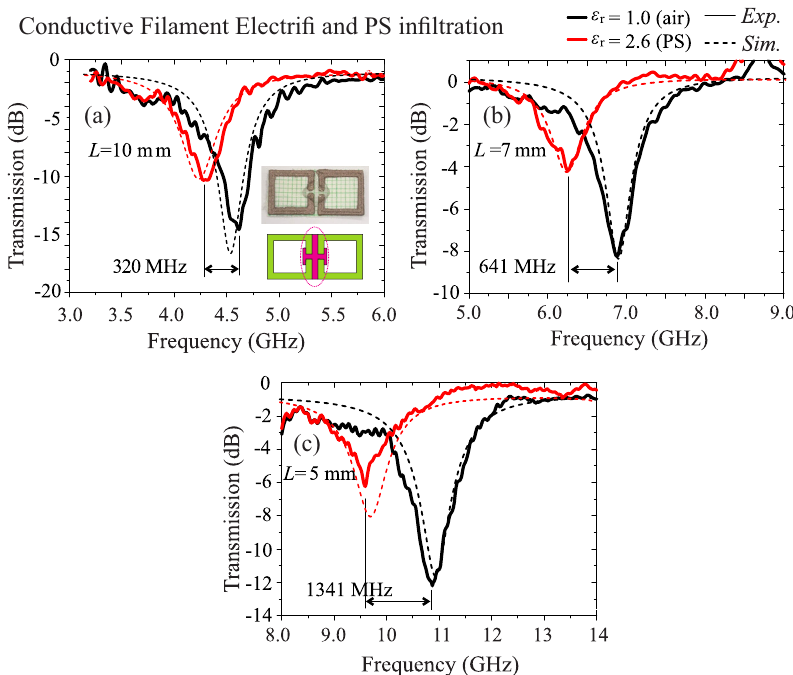
Figure 4. Tunability of the Electrifi SRRs with respect to the infiltrating polysterene ( ε r = 2.6). Experimental (solid) and numerical (dashed) investigation of the transmission tunability in the rectangular waveguide for variable length: ( a ) L = 10 mm, ( b ) L = 7 mm and ( c ) L = 5 mm. The insets in ( a ) show a photo of the area of the infiltration for the sample L = 10 mm and a schematic of the averaged infiltration area in magenta, used for the numerical